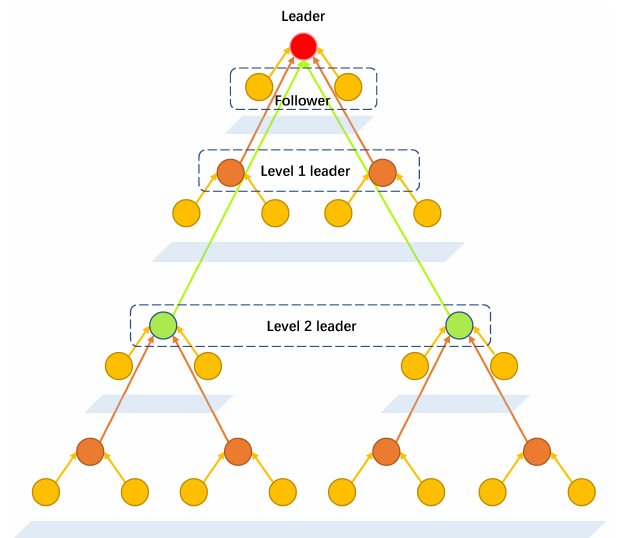
Figure 3. An example of a three-layer (leader ← level 2 leader ← level 1 leader ← follower) formation structure; the connection indicates the relationship between leader and follower, and the same color indicates the same level of